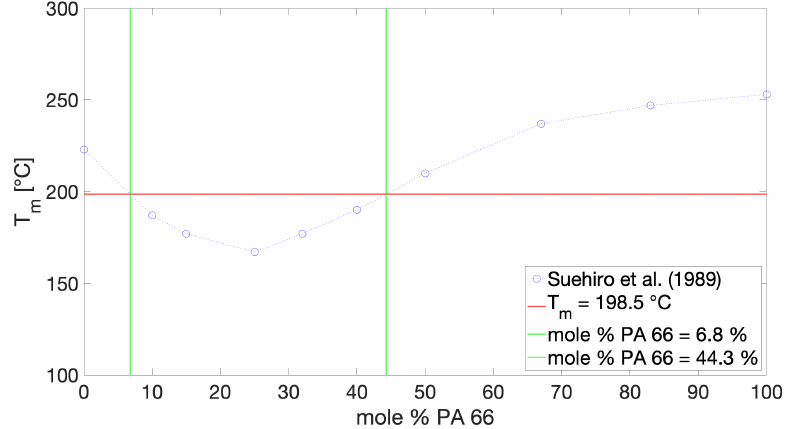
Figure A1. The melting temperature T m versus the molar concentration of PA 66 comonomer (blue dots) for PA 6/66 random copolymers as established by Suehiro et al. (1989) [76]. Both the employed value of the melting temperature (red line) and the two possible PA 66 molar comonomer fractions (green lines) are